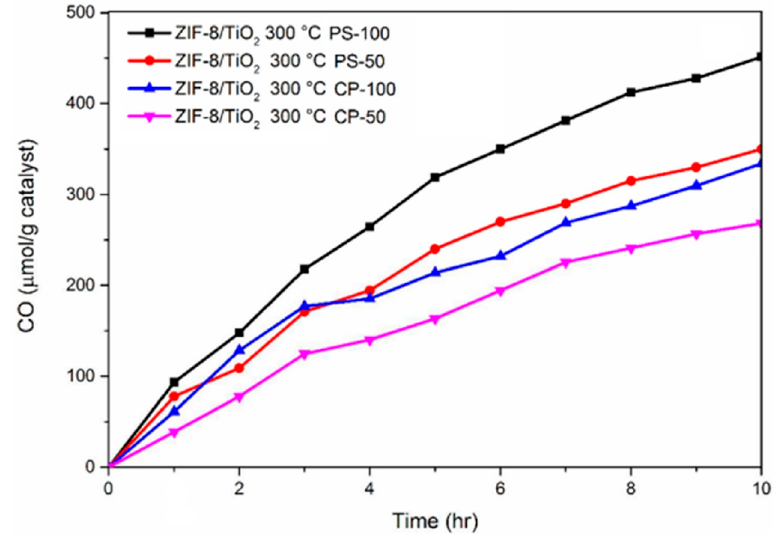
Figure 3. CO production for ZIF-8 / TiO 2 under constant pressure (CP, 5 bar) and pressure swing (PS, 5–3 bar) at flow rates of 50 and 100 mL min − 1 , reproduced with permission from reference [19]. Copyright Elsevier, 2017.